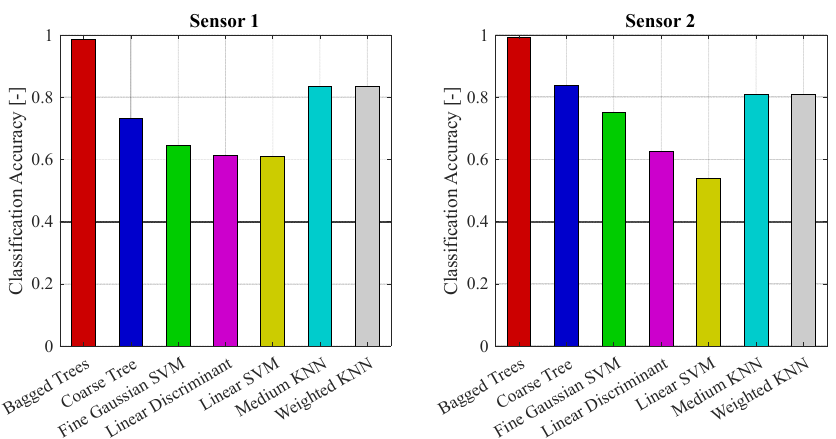
Figure 14. Classifier accuracy of raw signal with sensor 1 and sensor 2 (50 features).